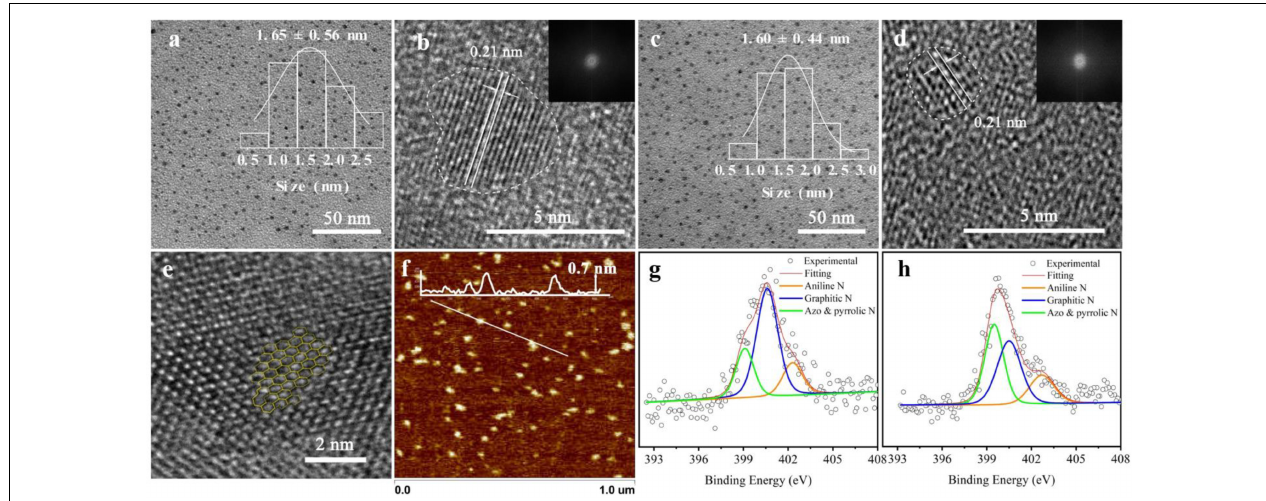
FIGURE 1 | Micromorphology and properties of graphene quantum dots (GQDs). (a,b) Transmission electron microscopy (TEM) and high-resolution (HR)-TEM images of GQDs-N [inset: particle size distribution in the TEM image and fast Fourier transform (FFT) pattern in the HR-TEM image]. (c,d) TEM and HR-TEM data of GQDs-M (inset: particle size distribution in the TEM image and FFT pattern in the HR-TEM image). (e) Part of the honeycomb structure of the GQDs. (f) Atomic force microscopy height sensor image of GQDs-N (inset: height profile along the white line). High-resolution N 1s XPS data of GQDs-N in panel (g) and GQDs-M in panel (h) ; the concentrations of the corresponding functional groups are included in Supplementary Table 2